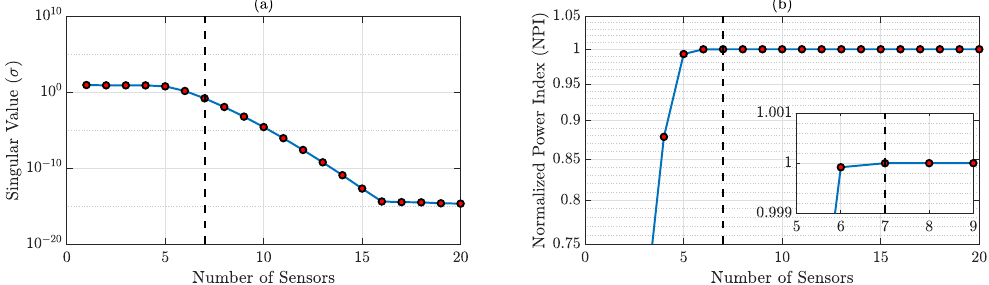
Figure 3. ( a ) SVD of the physics-guided basis matrix; ( b ) NPIs for different sensor numbers. NPI → 1 when the sensor number is 7 (shown in the zoomed-in